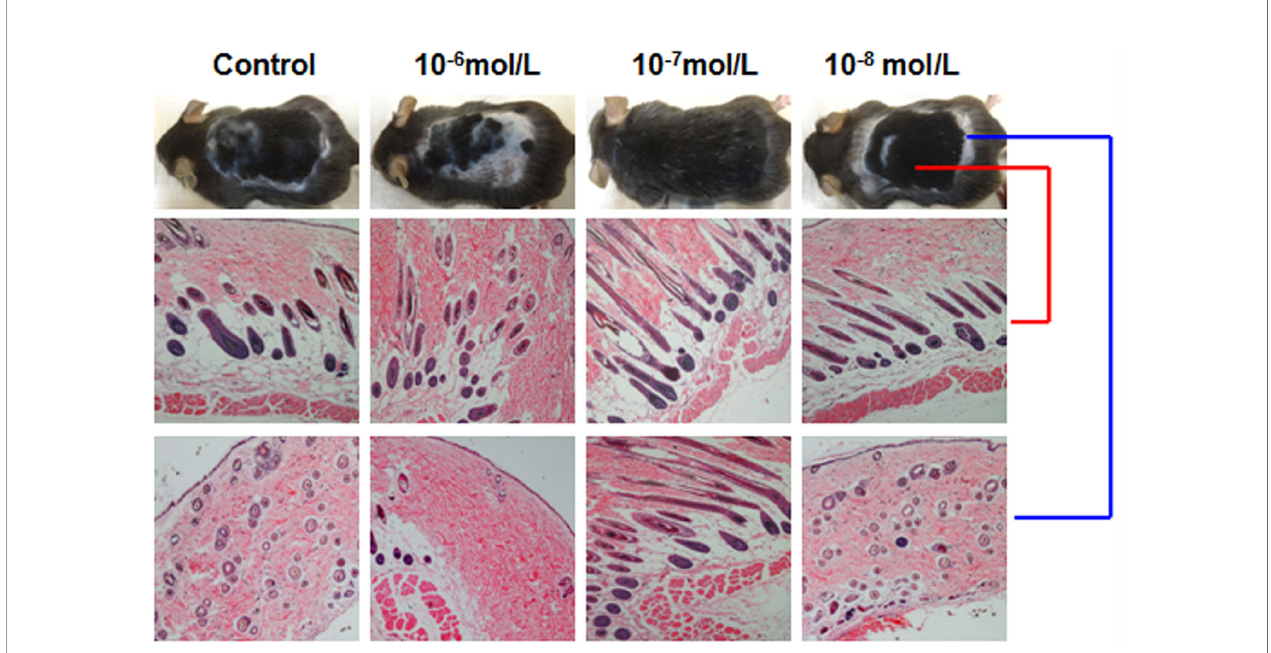
FIGURE 3 | Effects of different concentrations of dihydrotestosterone (DHT) on hair follicle morphology in C57BL/6 mice. The back skin of C57BL/6 mice at 18 days after treatment was shaved and then stained with hematoxylin and eosin. Representative HE staining images from mice treated with different concentrations of DHT are shown. The red line refers to back skin, while the blue line represents gray